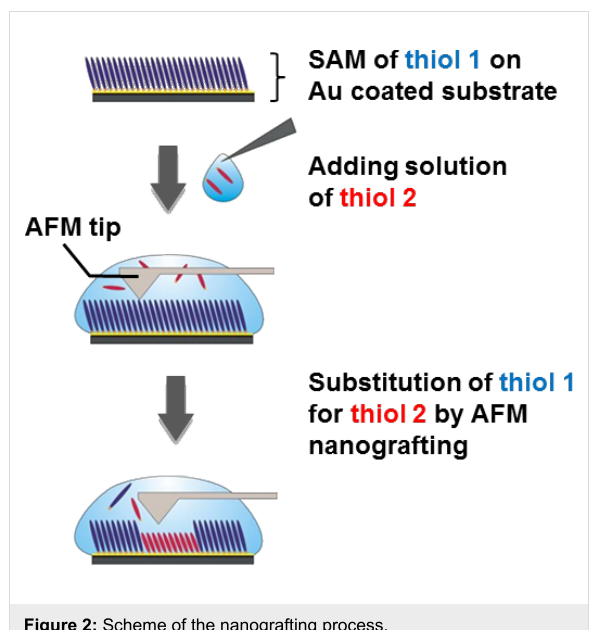
Figure 2: Scheme of the nanografting